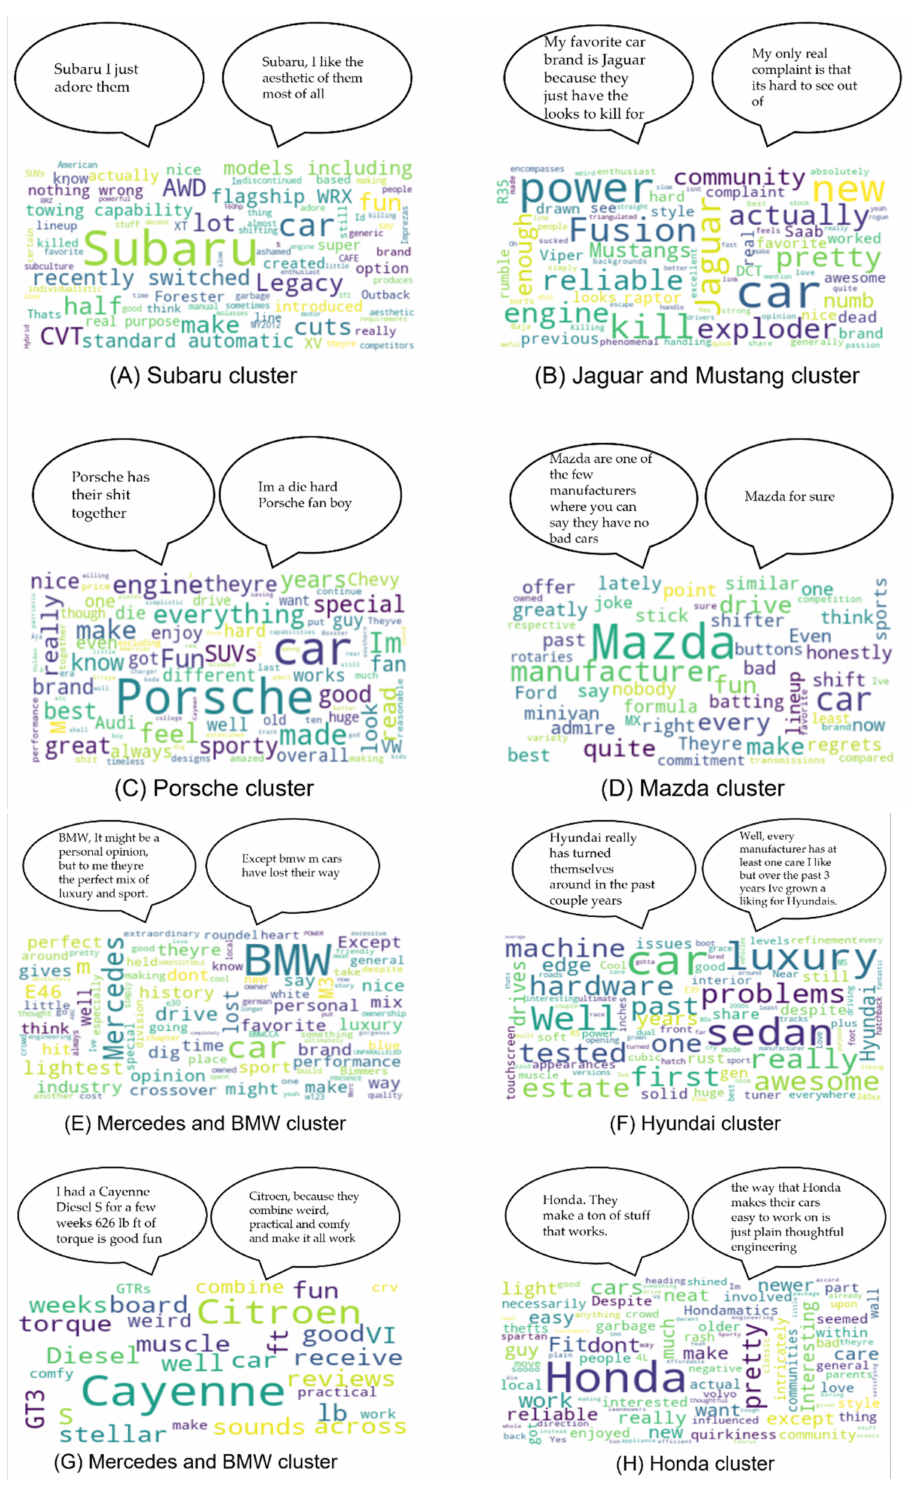
Figure 10. Word clouds with some clusters results of the car brands